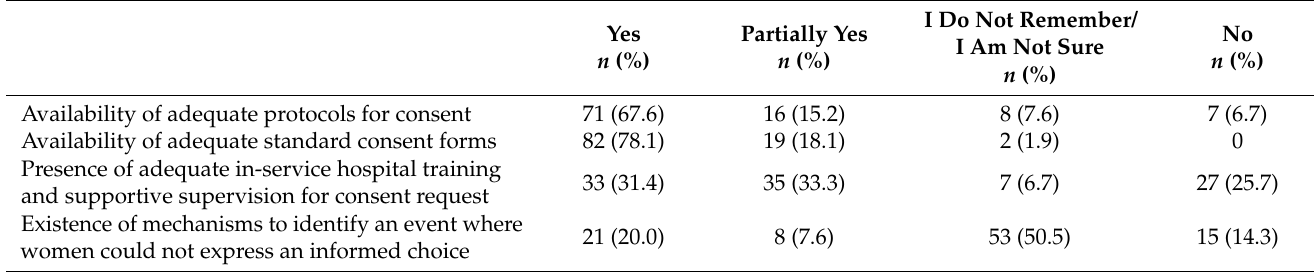
Table 3. Health workers’ perspectives on organizational factors and availability of resources for consent requests (N =